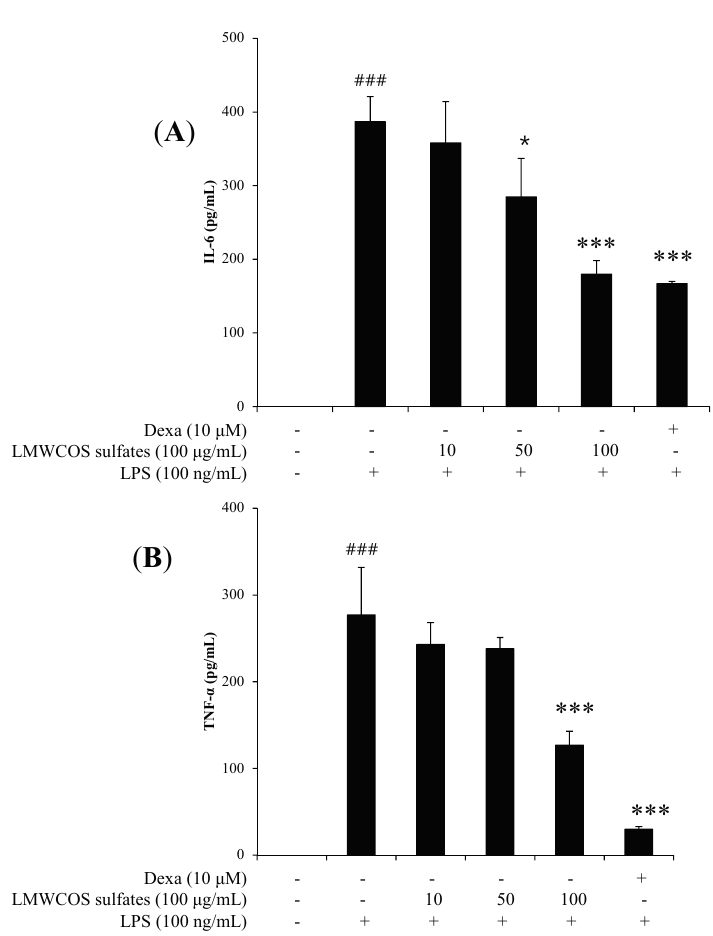
Figure 5. The effects of LMWCOS sulfates on pro-inflammatory cytokines by LPS-stimulated RAW264.7 cells. RAW264.7 cells were treated with the indicated doses of S-LMWCOSs 1 h before LPS treatment (100 ng/mL). After incubation of 24 h, the supernatants were taken, and the amounts of IL-6 ( A ) TNF- α ( B ) were measured by ELISA. Dexamethasone (Dexa) used as positive control. Results are expressed as mean ± SEM from three independent experiments. ### p < 0.001 versus control, * p < 0.05, *** p < 0.001 versus LPS alone